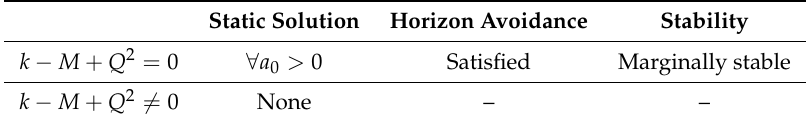
Table 1. The existence and stability of static wormholes in three dimensions.